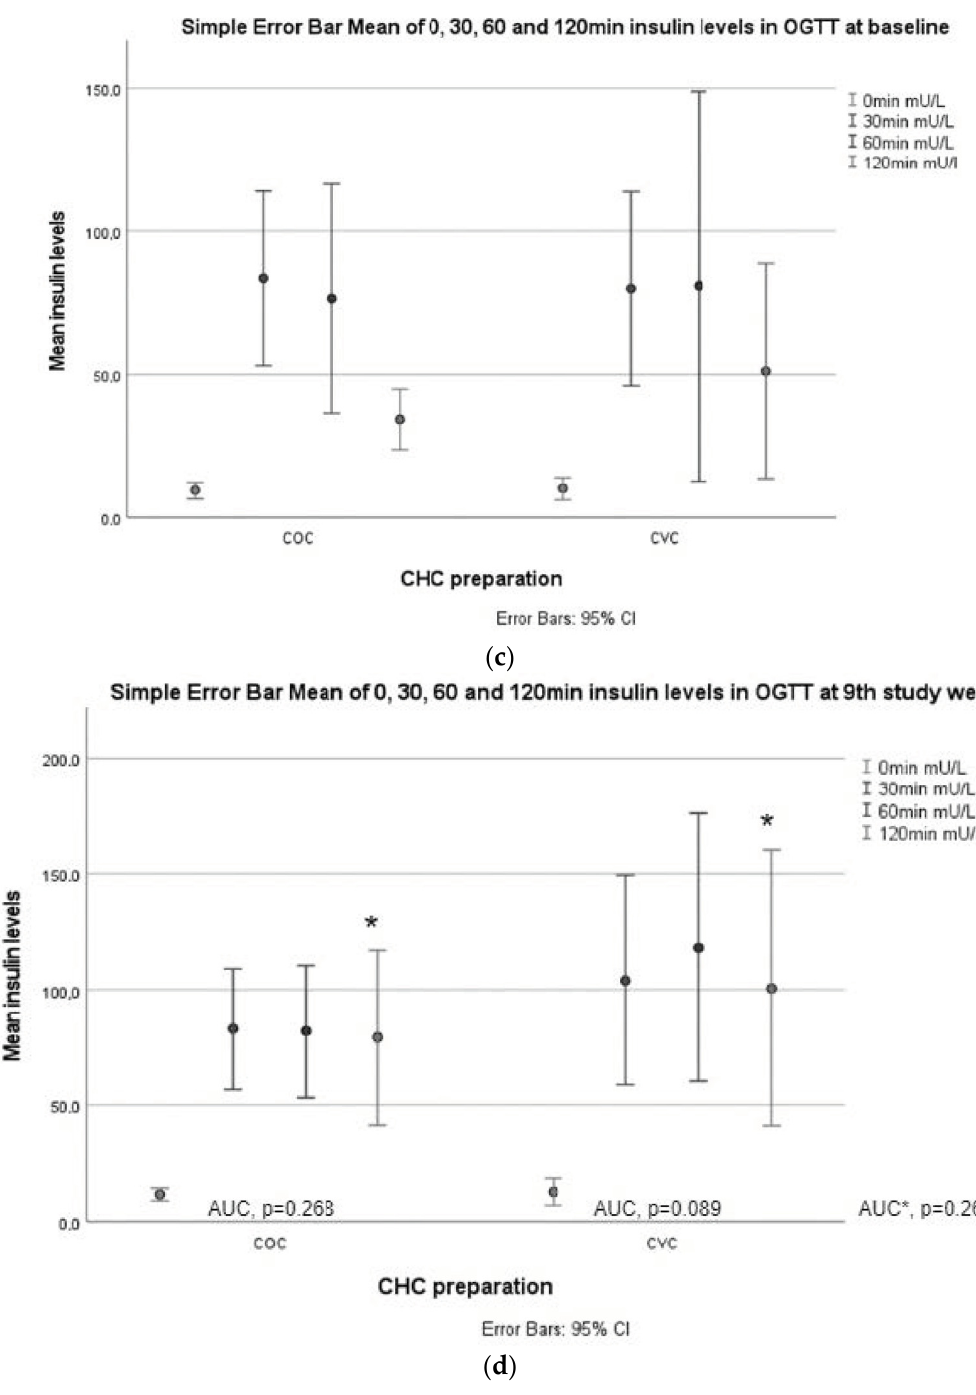
Figure 2. Glucose and insulin responses during OGTT. ( a ) Glucose values at 0, 30, 60, and 120 min in both study groups at baseline; ( b ) glucose values at 0, 30, 60, and 120 min in both study groups week 9. AUCglucose values between baseline and the ninth week in the COC and CVC groups. AUC * is AUCglucose between the study groups. An asterisk (*) marks a significant increase in 60 min glucose value in the CVC group compared to baseline; ( c ) insulin values at 0, 30, 60, and 120 min in both study groups at baseline.; ( d ) insulin values at 0, 30, 60, and 120 min in both study groups at baseline. AUCinsulin values between baseline and the ninth week in the COC and CVC groups. AUC * is AUCinsulin between the study groups at week 9. An asterisk (*) marks a significant increase in 120 min insulin values in both groups compared to baseline.